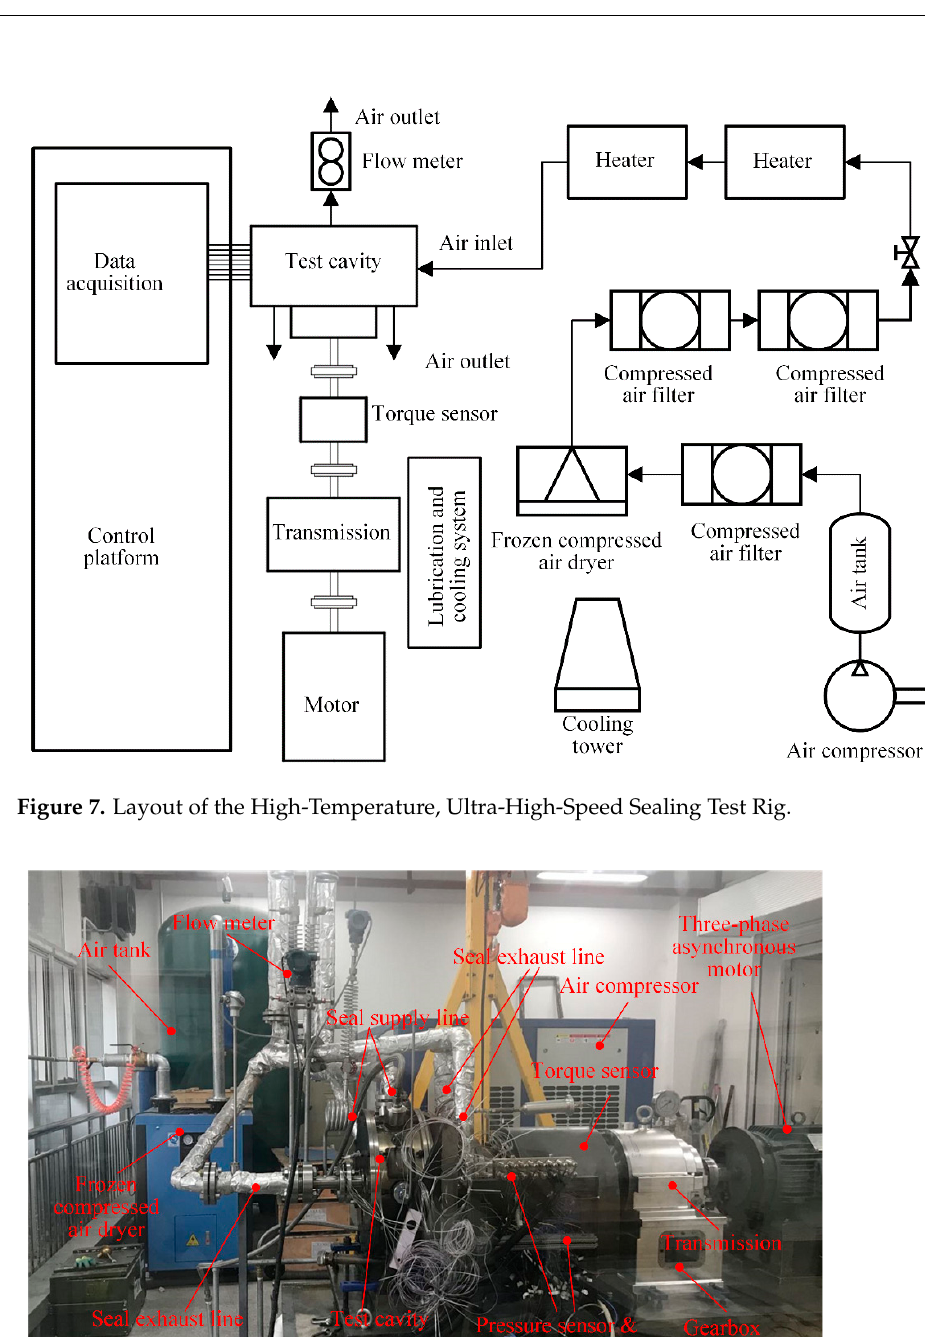
Figure 9. Partial schematic diagram of the test cavity.